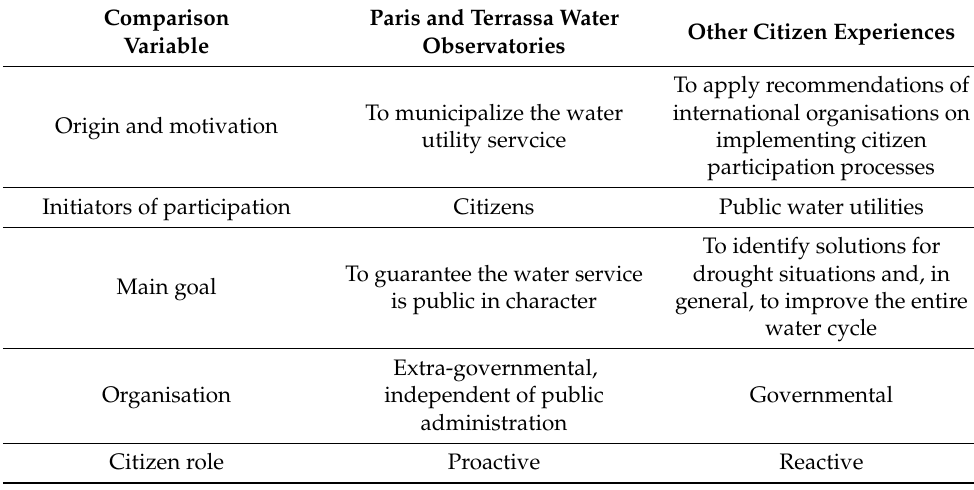
Table 1. Comparative analysis of citizen experiences aimed at better water management and the Paris and Terrassa Water Observatories. (Source: